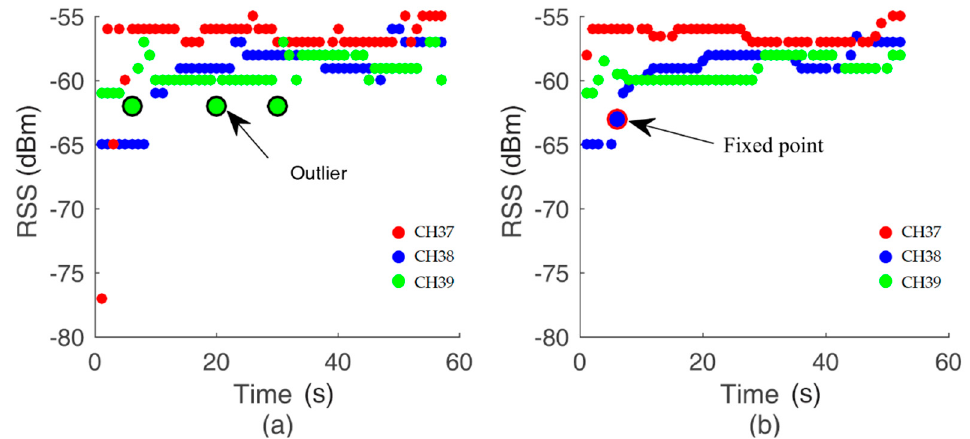
Figure 5. The scatter plot of ( a ) raw data; ( b ) processed data. Here, 𝑊𝐿 (cid:2869) is 5 in Equation (3).